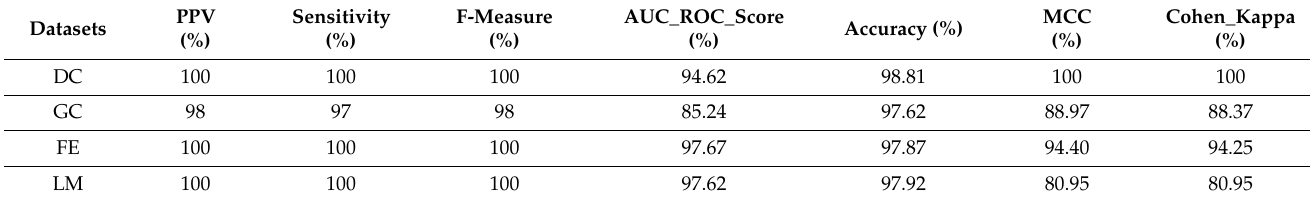
Table 7. Results of Max voting